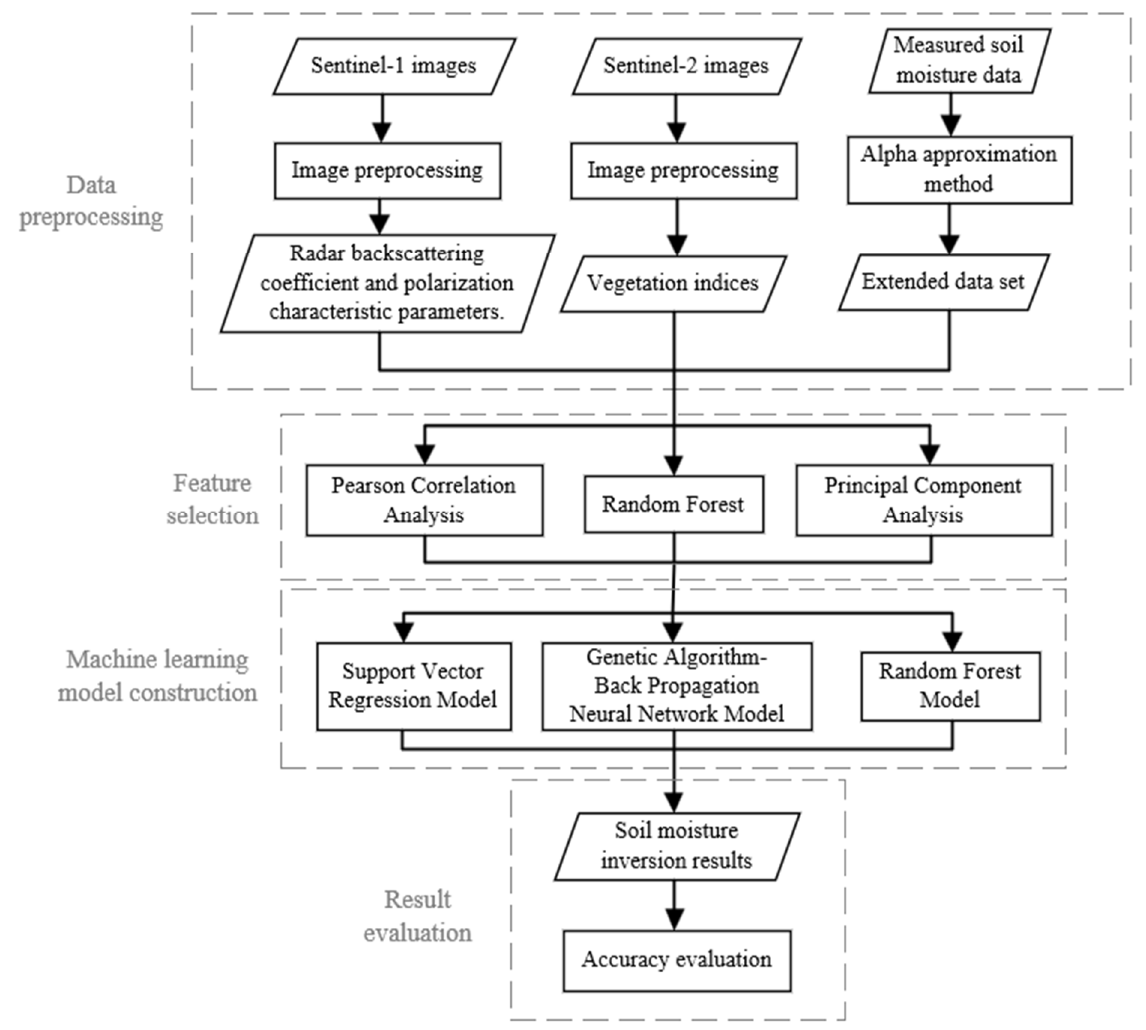
Figure 2. Technology roadmap of the proposed method.